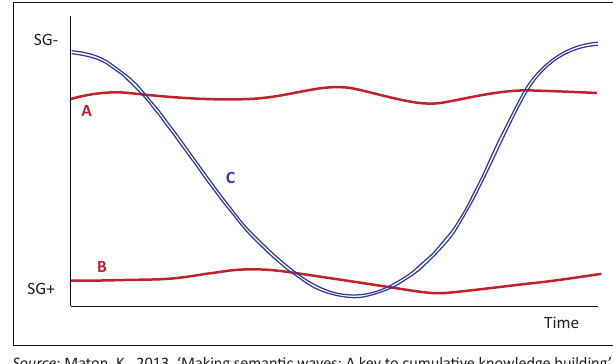
FIGURE 1: Illustrative example of semantic